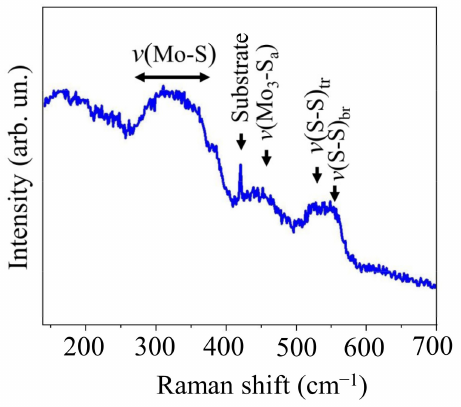
Figure 12. Raman spectra of MoS x ~4 film obtained by on-axis RPLD on a sapphire